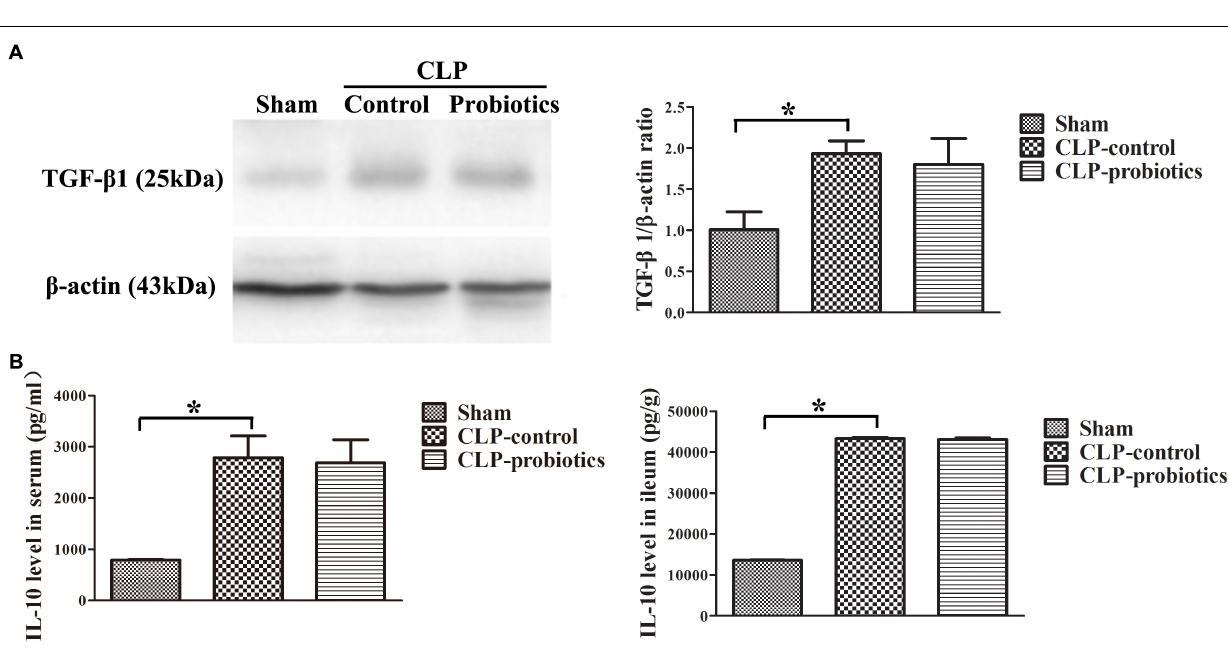
FIGURE 4 | The levels of anti-inflammatory TGF- β 1 and IL-10 in the septic mice with or without LCBE treatment. (A) The protein expressions of TGF- β 1 in each group were determined by Western blotting assay (left panel). The quantitative analysis of TGF- β 1 bands was presented in right panel. (B) IL-10 levels in serum and ileal tissues were detected by ELISA. All data were showed as means ± SEM. N = 6 mice/group; ∗ P <